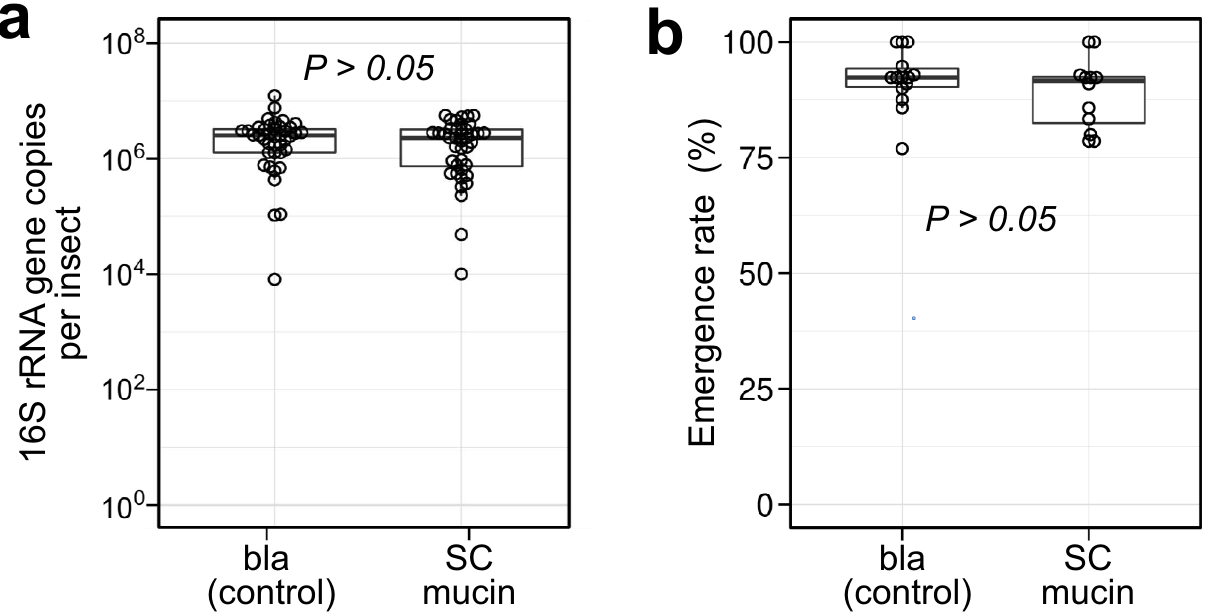
Figure 8. Effects of maternal SC mucin RNAi on vertical symbiont transmission. ( a ) The symbiont titers in the progenies of control (bla dsRNA injected) females and SC mucin dsRNA injected females. For each group, the symbiont titer of 40 s-instar nymphs derived from 10 treated females was assessed by qPCR. ( b ) Adult emergence rate of the offspring. In total, 14 egg masses from 7 control (bla RNAi) females (201 hatched nymphs in total) and 12 egg masses from 6 SC mucin RNAi females (164 hatched nymphs in total) were subjected to nymphal rearing to adulthood to collect the data of adult emergence rate per egg mass. Adults that emerged within a normal growth period (27 days from hatching) were counted. In both ( a ) and ( b ), the difference between the experimental groups was statistically not significant (likelihood ratio test for GLM, P >